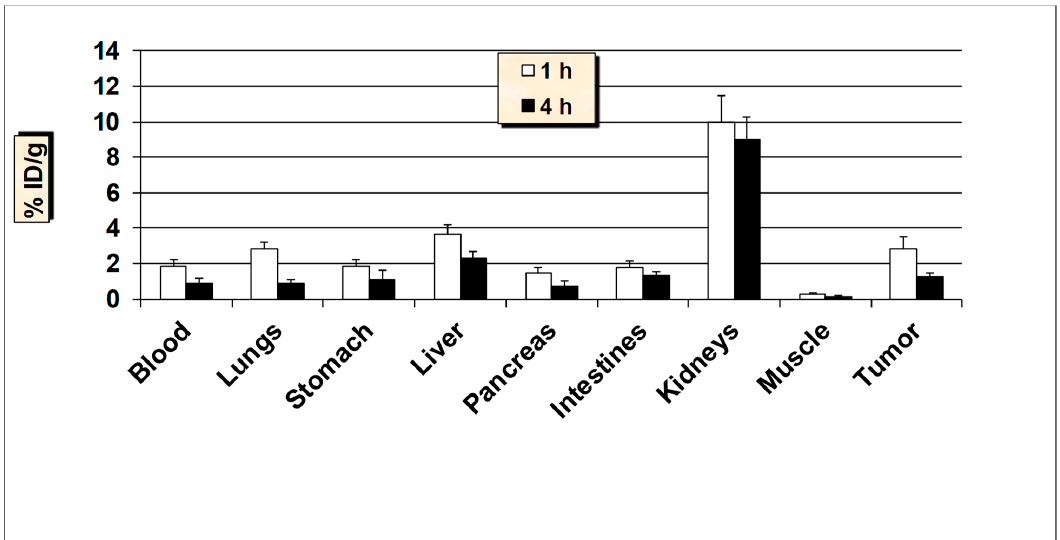
Figure 6. In vivo tumor targeting studies of 99m Tc-HER2-derived peptide in HER2-positive SKBR3 breast cancer xenografts mice models. Data is represented as % injected dose per gram (% ID / g)